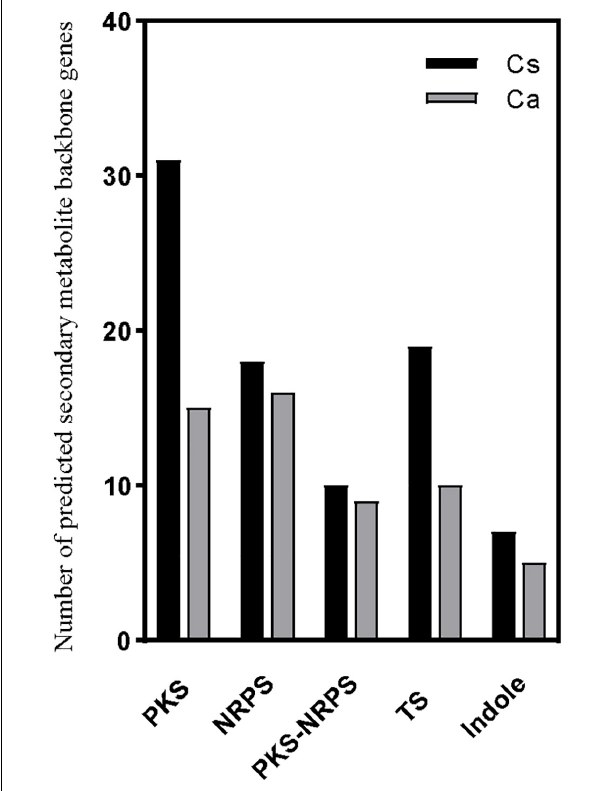
FIGURE 5 | Number of secondary metabolite backbone genes predicted by antiSMASH in the two species of Colletotrichum . PKS, polyketide synthase; NRPS, non-ribosomal peptide synthetase; PKS-NRPS, PKS-NRPS hybrid containing at least one PKS and one NRPS domain; TS, terpene synthase. Cs, C. siamense ; Ca, C. australisinense.